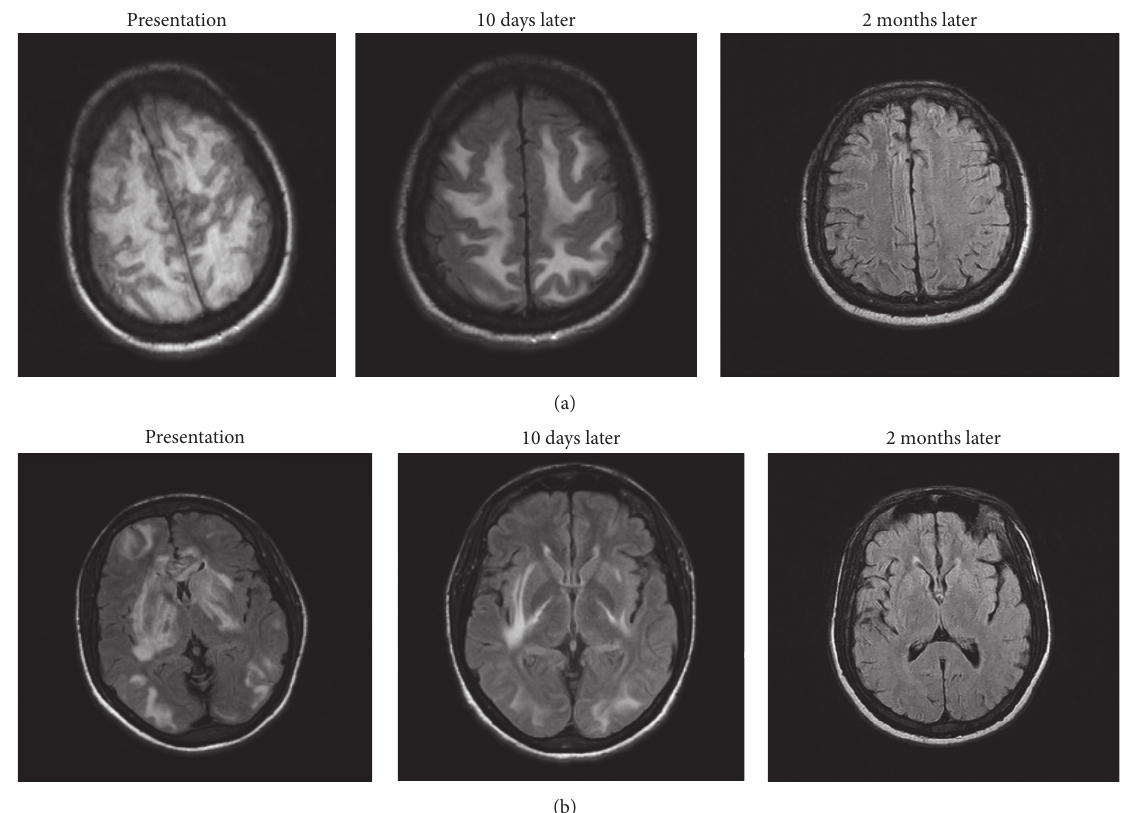
Figure 4: MRI Brain-Axial FLAIR-weighted images demonstrate improvement in the areas of edema over 10 days and 2